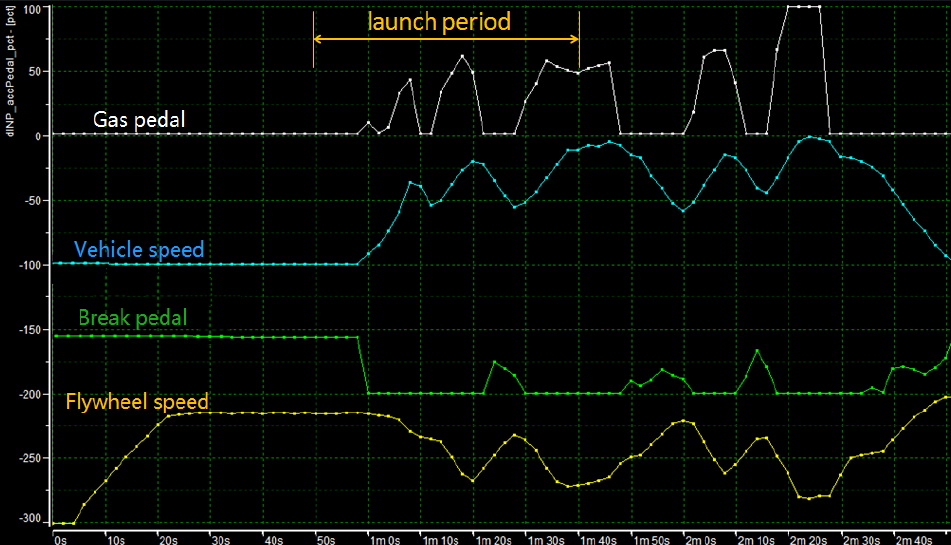
Figure 9. Tested range-extended electric light truck with i-KERD assembly shown in the chassis.